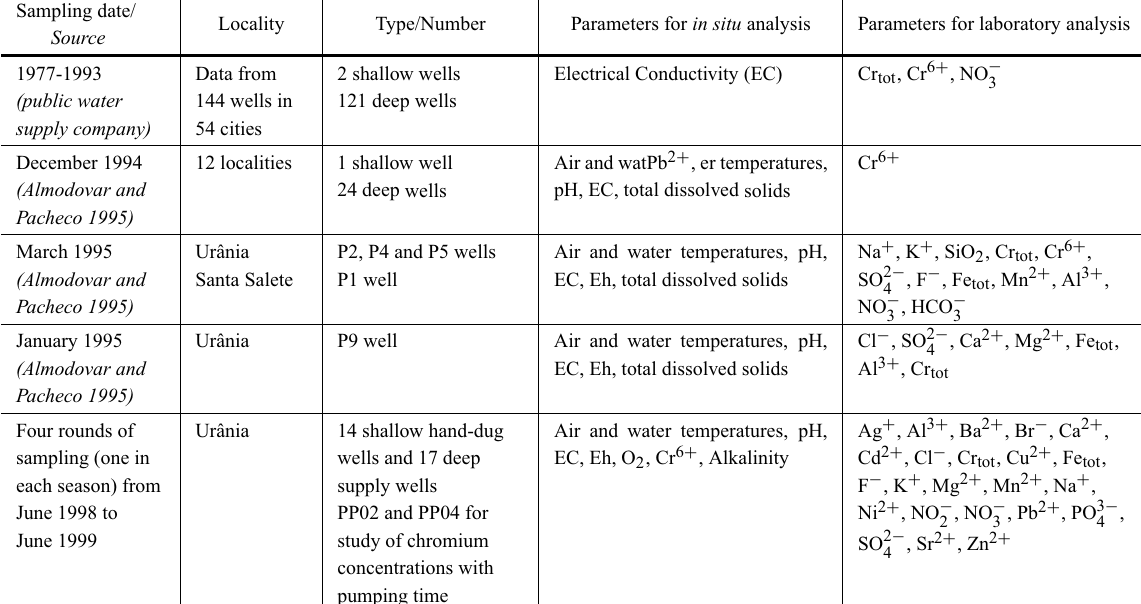
Characteristics of groundwater sampling events from 1977 to 1999.